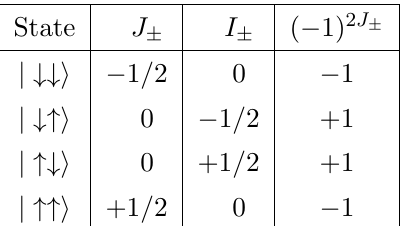
Table 1 . Long representation of the chiral superalgebra. In this table (cid:6) denote the right- and left- moving sectors. The two arrows of the state denote the eigenvalues under the Cartan generators ^ of SU(2) and SU(2) ( " has value + 1 and # has value (cid:0) 1 ). 2 2 where ‘ is the orbital angular momentum (not to be confused with the summation variable ‘ appearing in section 1) . Moreover, short multiplets contribute in the same way to I ( (cid:21) ; y ) and I ( (cid:21) ; y; 0) when (cid:21)q > 0, or to I ( (cid:21) ; y ) and I (cid:0) ( (cid:21) ; y; 0) when (cid:21)q < 0, and in both +